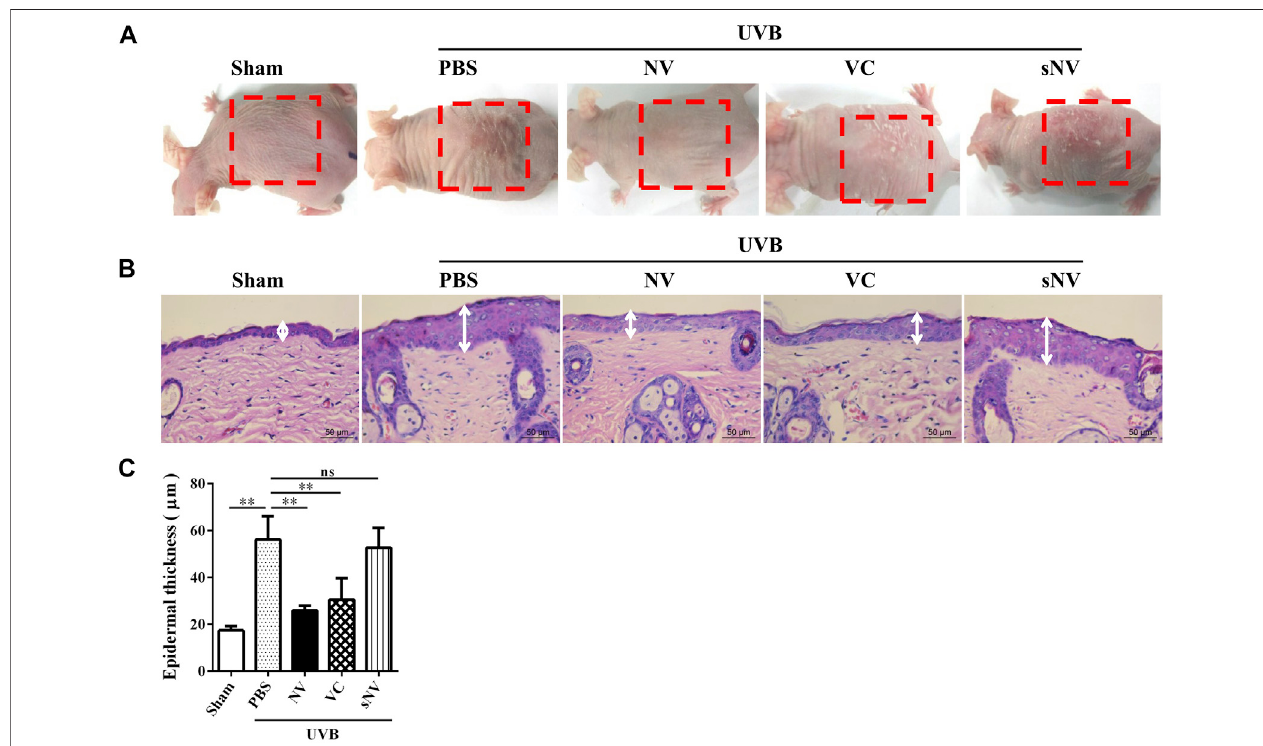
FIGURE 3 | Topical application of antioxidin-NV signi fi cantly suppressed UVB-induced skin photoaging in hairless mice, obviously decreased skin erythema, thickness and wrinkle formation. (A) Images of a representative mouse from each group taken after 12 weeks are shown. 200 mJ/cm 2 UVB radiation and vehicle, antioxidin-NV, VC or sNV (the scrambled version ofantioxidin-NV) were used to treat the back skin ofmice for 12 weeks. The red dotted line indicated the UVB-induced skin photoaging: decreasedskinerythema,coarsewrinkling,roughtextureand thickening. (B) skintissuesweretakenandparaf fi nblockswerecutinto4 μ mthick sections forHEstaining,andthewhitelineindicatedthethicknessoftheepidermis.Scalebar (cid:1) 50 μ m. (C) Epidermalthicknessesineachgroupofmiceweremeasured and analyzed. Data are presented as mean ± SD ( n (cid:1) 6). ns, no signi fi cance, ** p < 0.01.